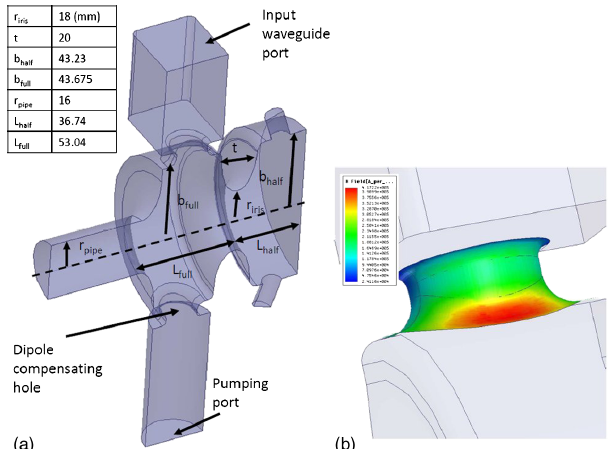
FIG. 2. (a) HFSS geometry of the rf gun; (b) detail of the surface peak magnetic field on the coupling hole at 120 MV = m on the cathode.